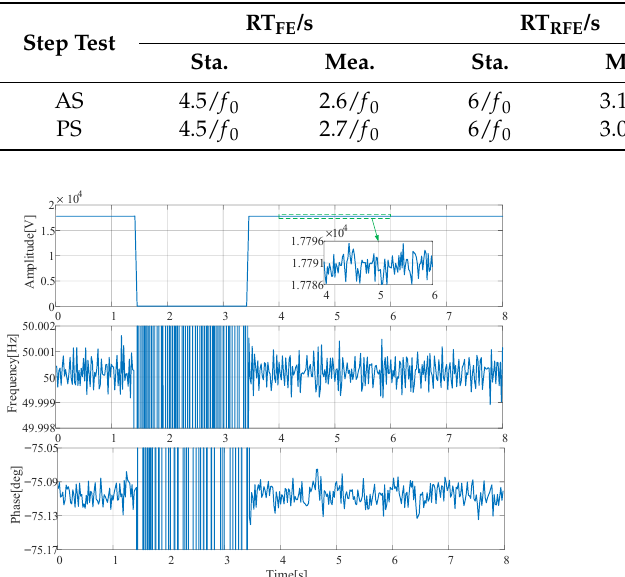
Figure 15. Measurement results of the PMU prototype under single-phase grounding fault.